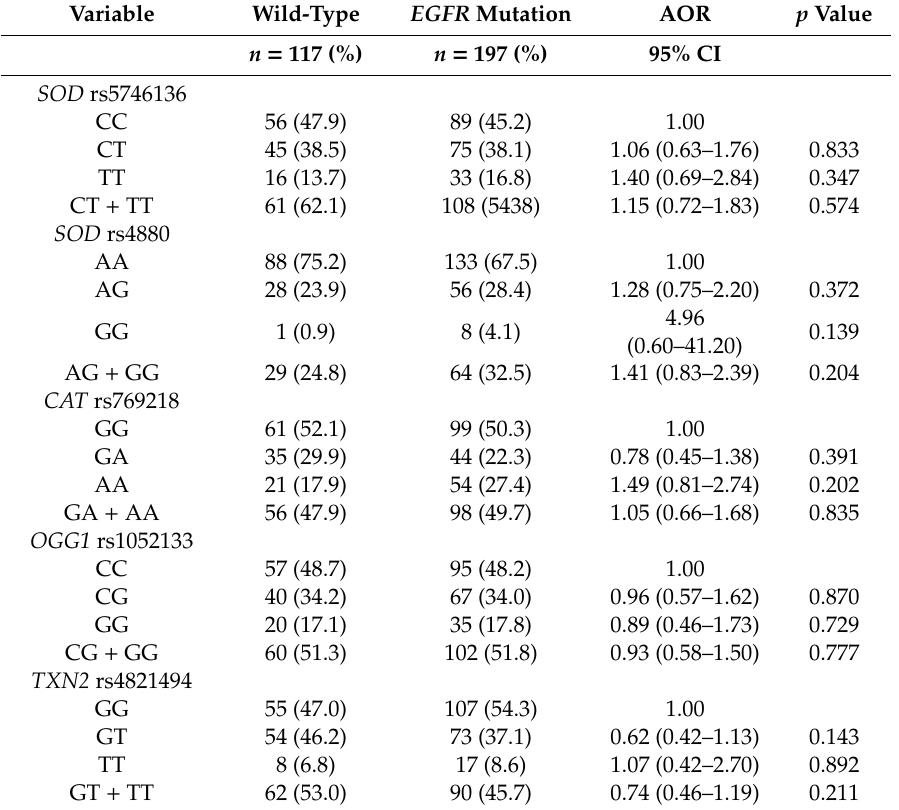
Table 2. Distribution frequency of antioxidant gene polymorphism with lung adenocarcinoma and logistic regression of EGFR mutation